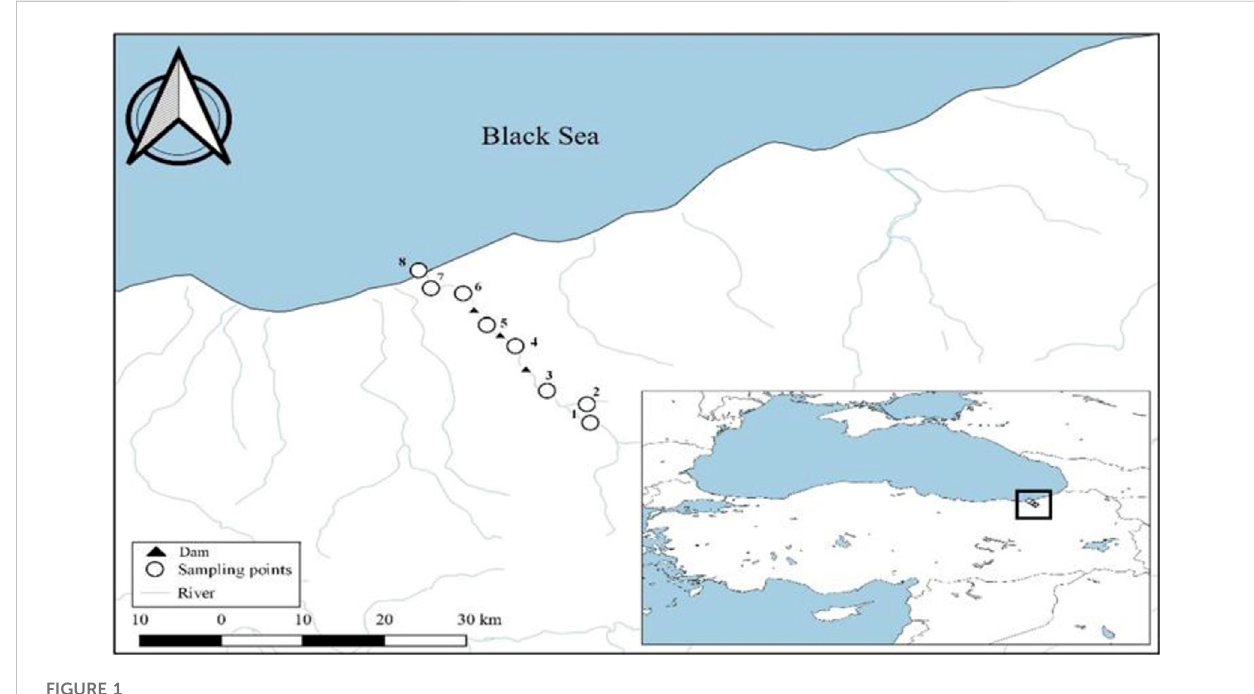
FIGURE 1 Iyidere River Basin with sampling